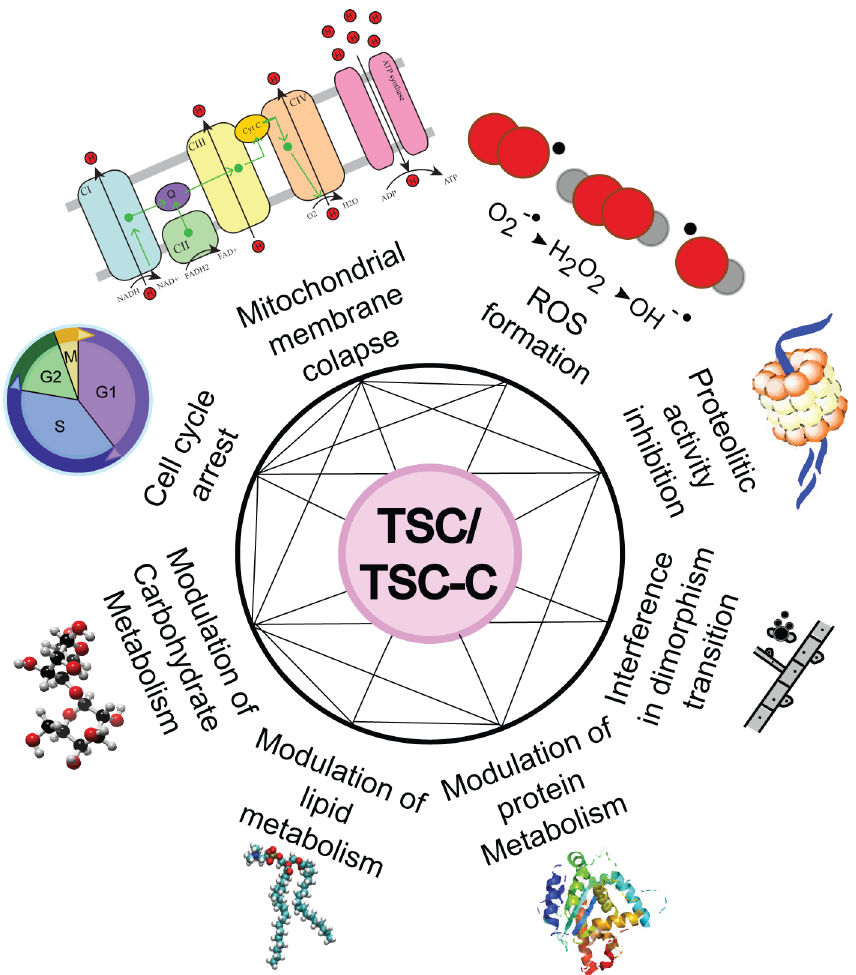
Fig 4. Main cellular processes influenced by TSC and TSC-C based on a comparison between the transcriptomic, proteomic, and chemoproteomic data.